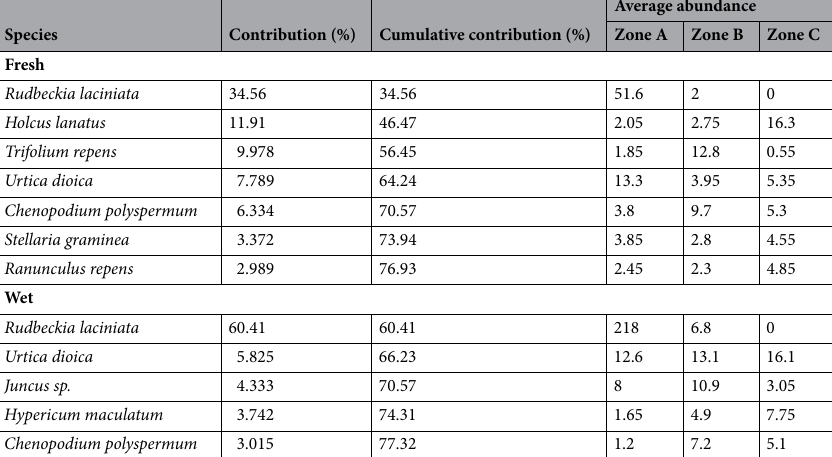
Table 4. Results of SIMPER analysis. Contribution of the most important species present in the soil seed bank to the dissimilarity between the subsequent zones in the fresh and in the wet meadow.